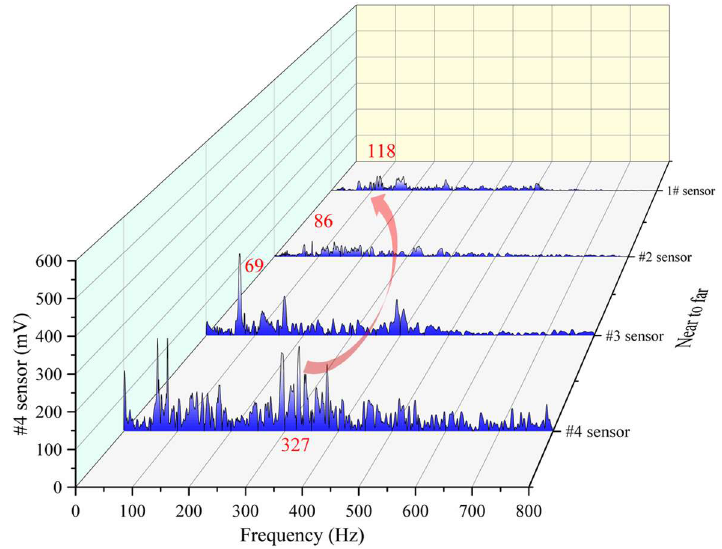
Figure 12. Main frequency decreasing case event.